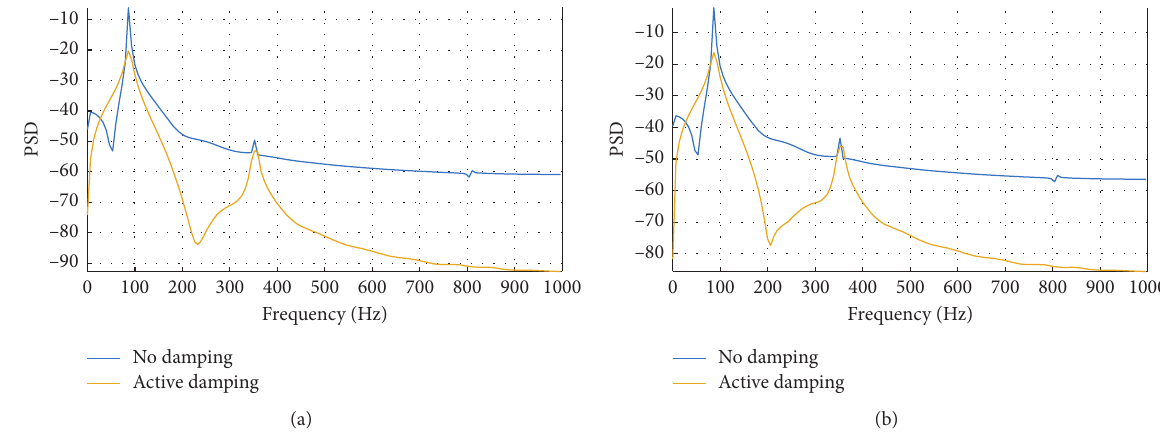
Figure 12: PSD of the first three modes of each link for the 3 rd trajectory. (a) 1 st link. (b) 2 nd